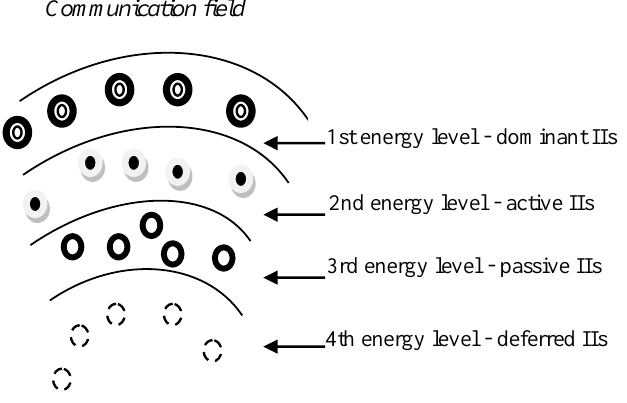
Figure 1. The energy levels in the individual’s communication field.